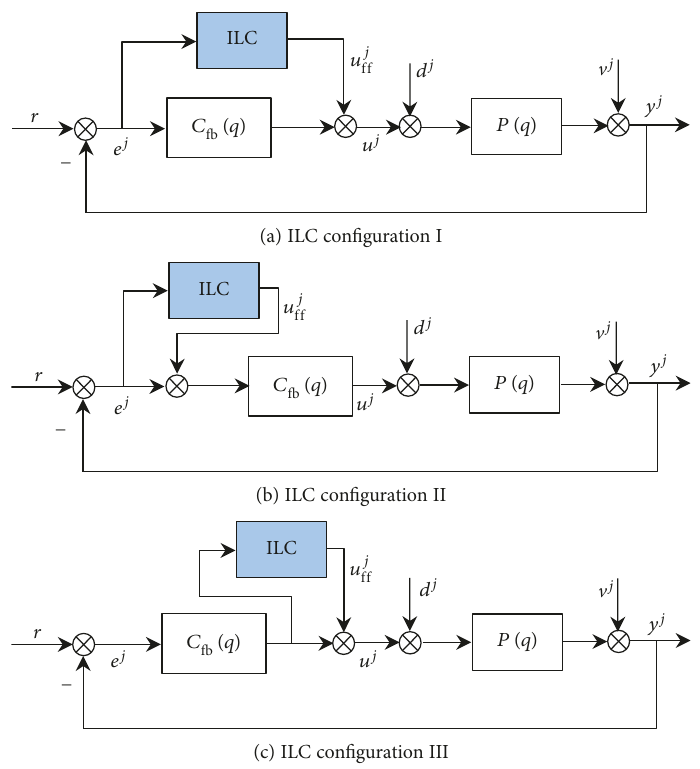
Figure 4: Two DOF control structures with di ff erent ILC con fi